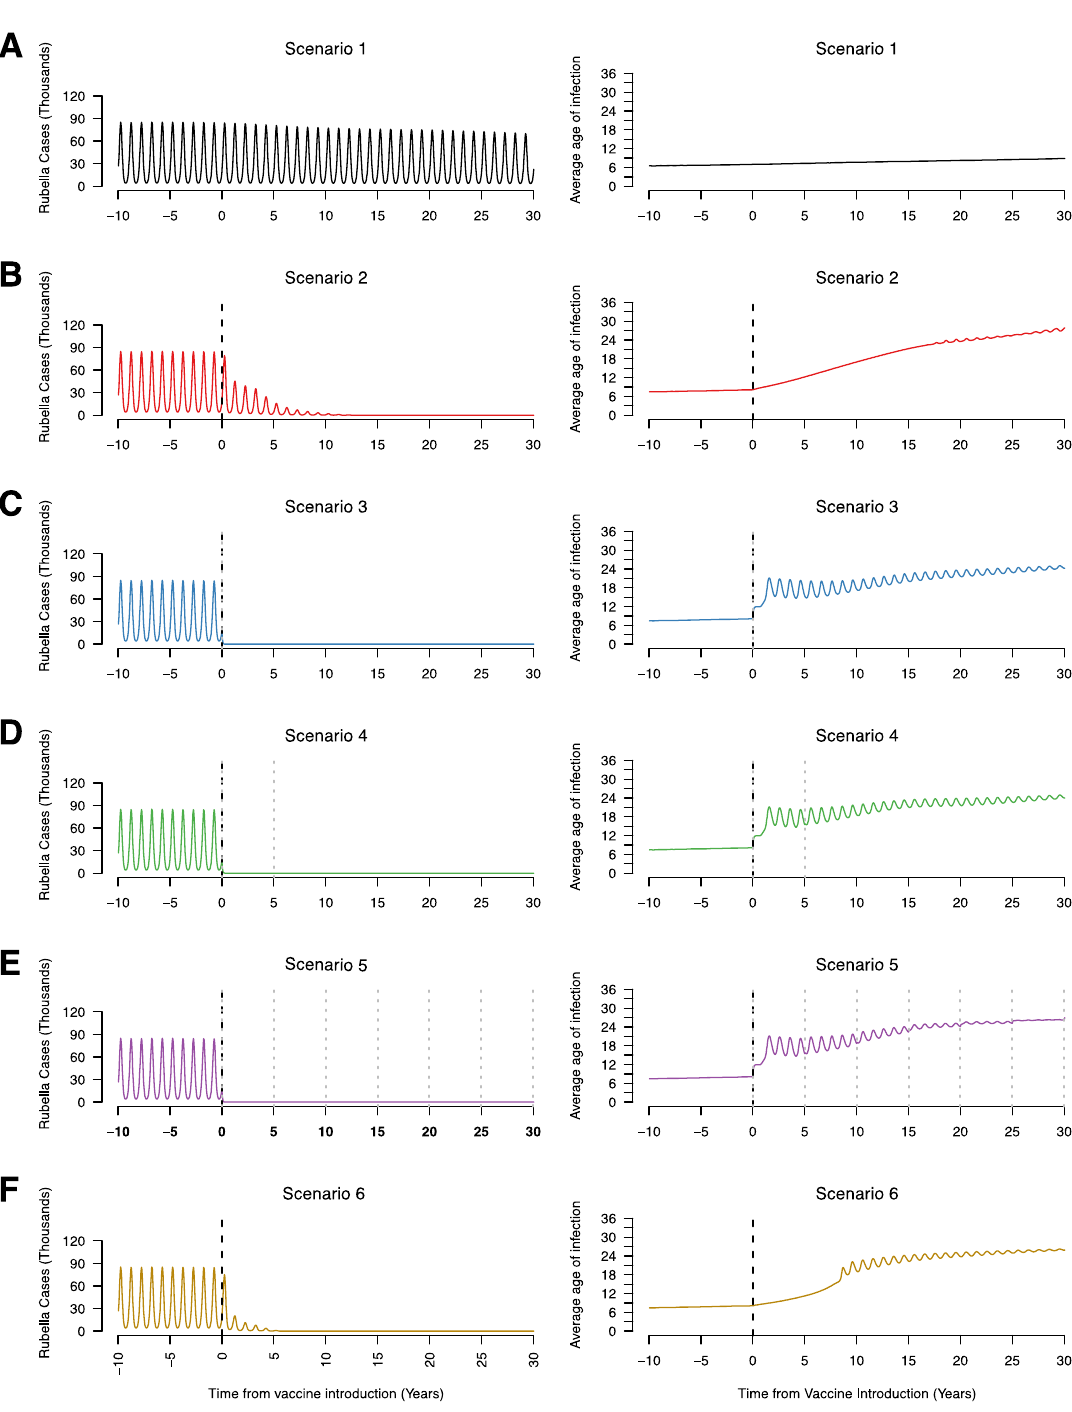
Figure 1. Time series of the annual number of rubella infections (in thousands) and average age of infection for scenario 1 ( A ), scenario 2 ( B ), scenario 3 ( C ), scenario 4 ( D ), scenario 5 ( E ), and scenario 6 ( F ), assuming 80% RCV coverage in routine and campaigns if relevant to the scenario. The vertical black dotted line represents the year of RCV introduction (year zero) and the grey dotted lines represent supplementary immunization activities (SIAs).